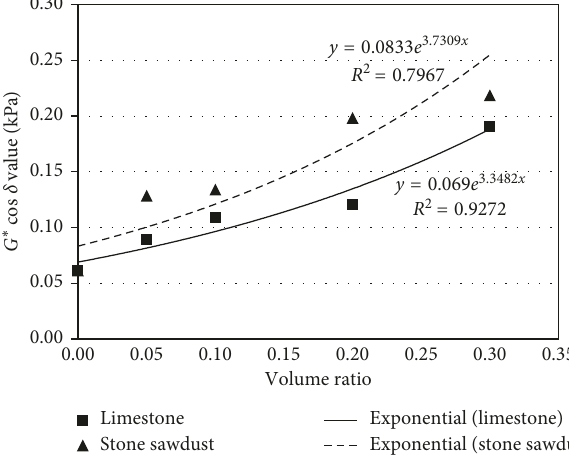
Figure 9: Elastic behavior of asphalt mastics at 70 ° C and 1.78Hz versus VR.